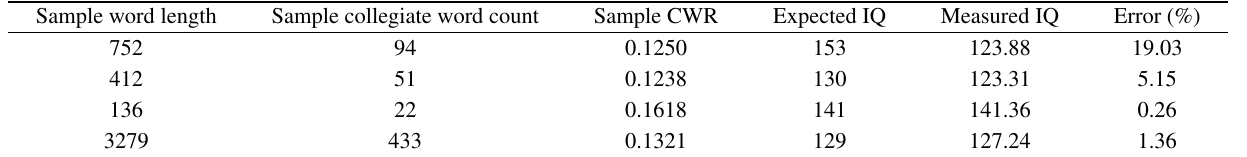
Table 3 Expected IQ vs. measured IQ [34] .